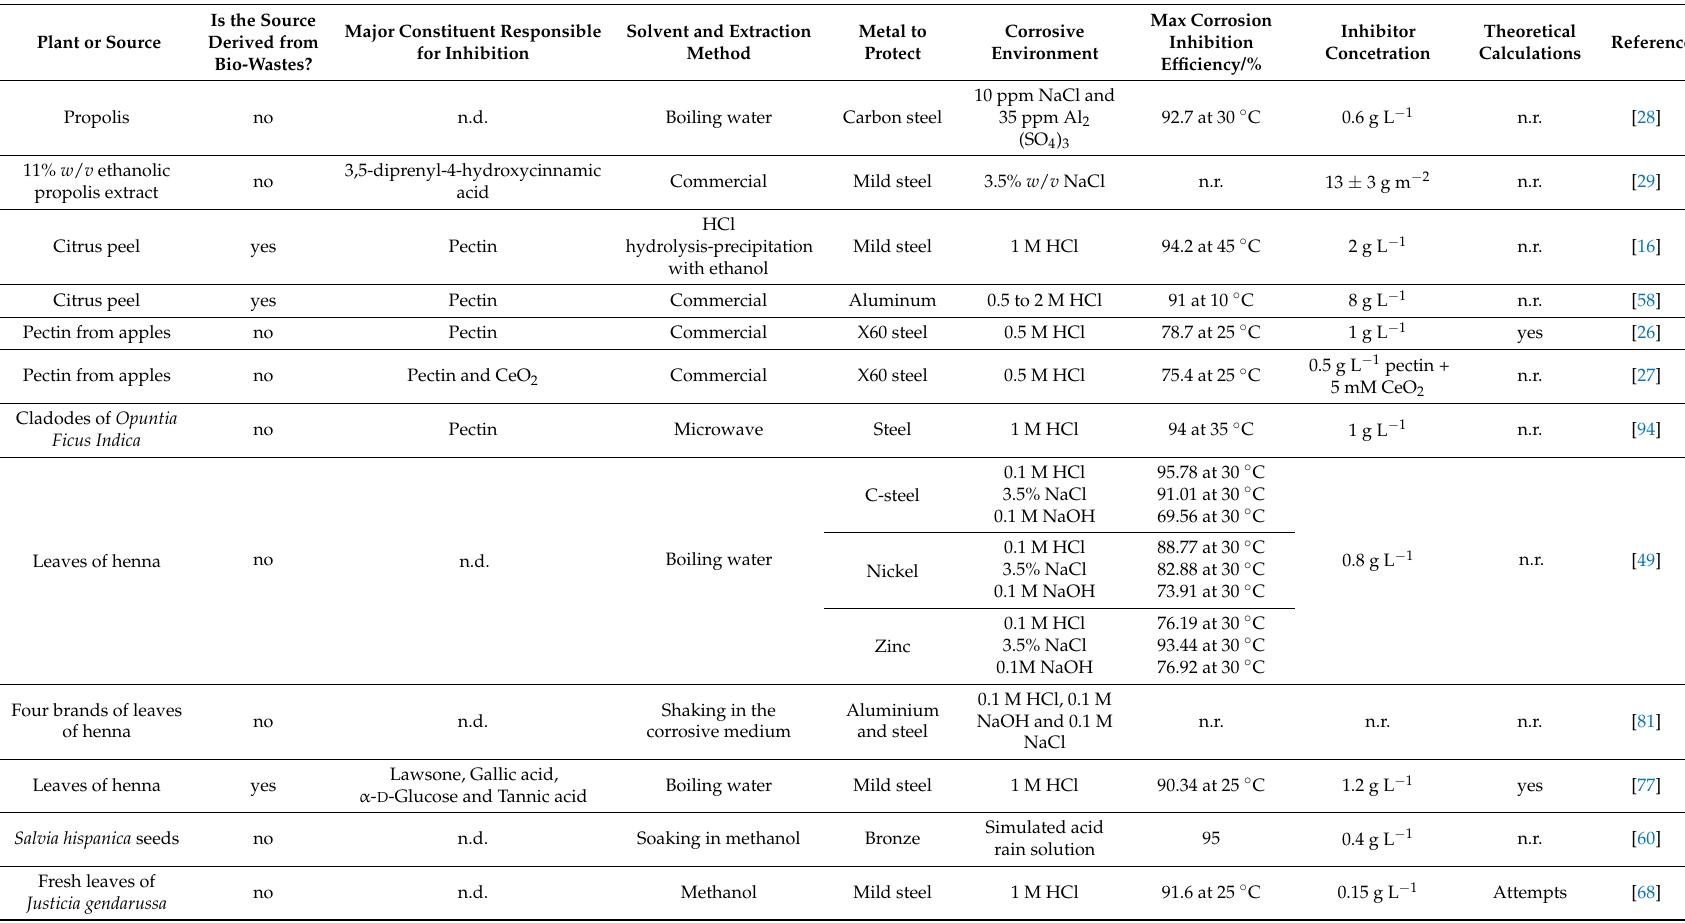
Table 1. Summary of the main features of the cited green extracts employed as corrosion